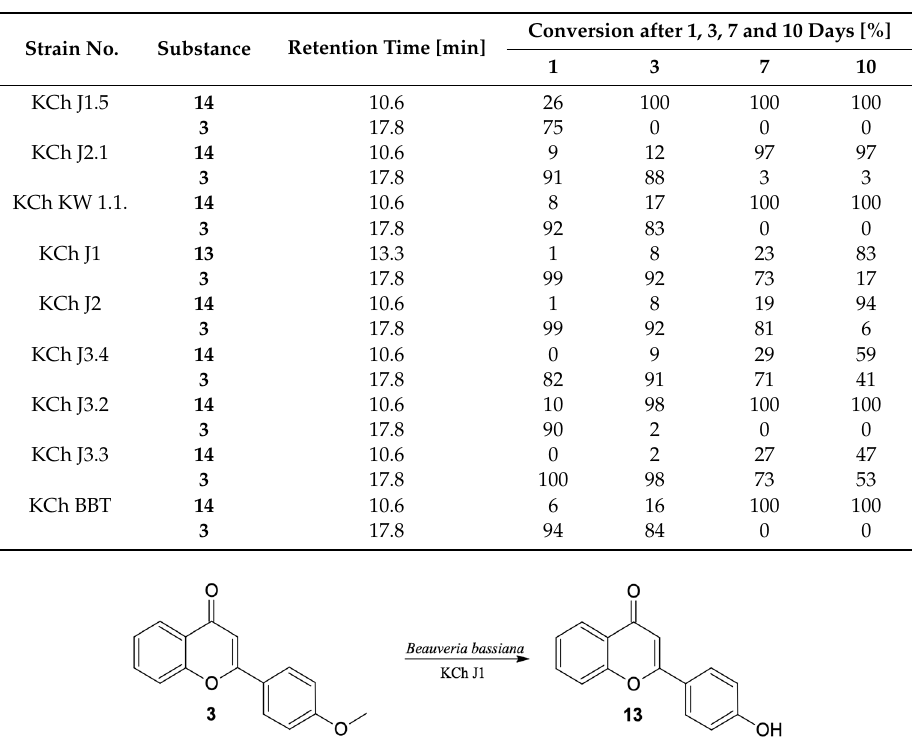
Figure 5. Biotransformation of 4 ′ -methoxyflavone ( 3 ) by B. bassiana KCh J1.